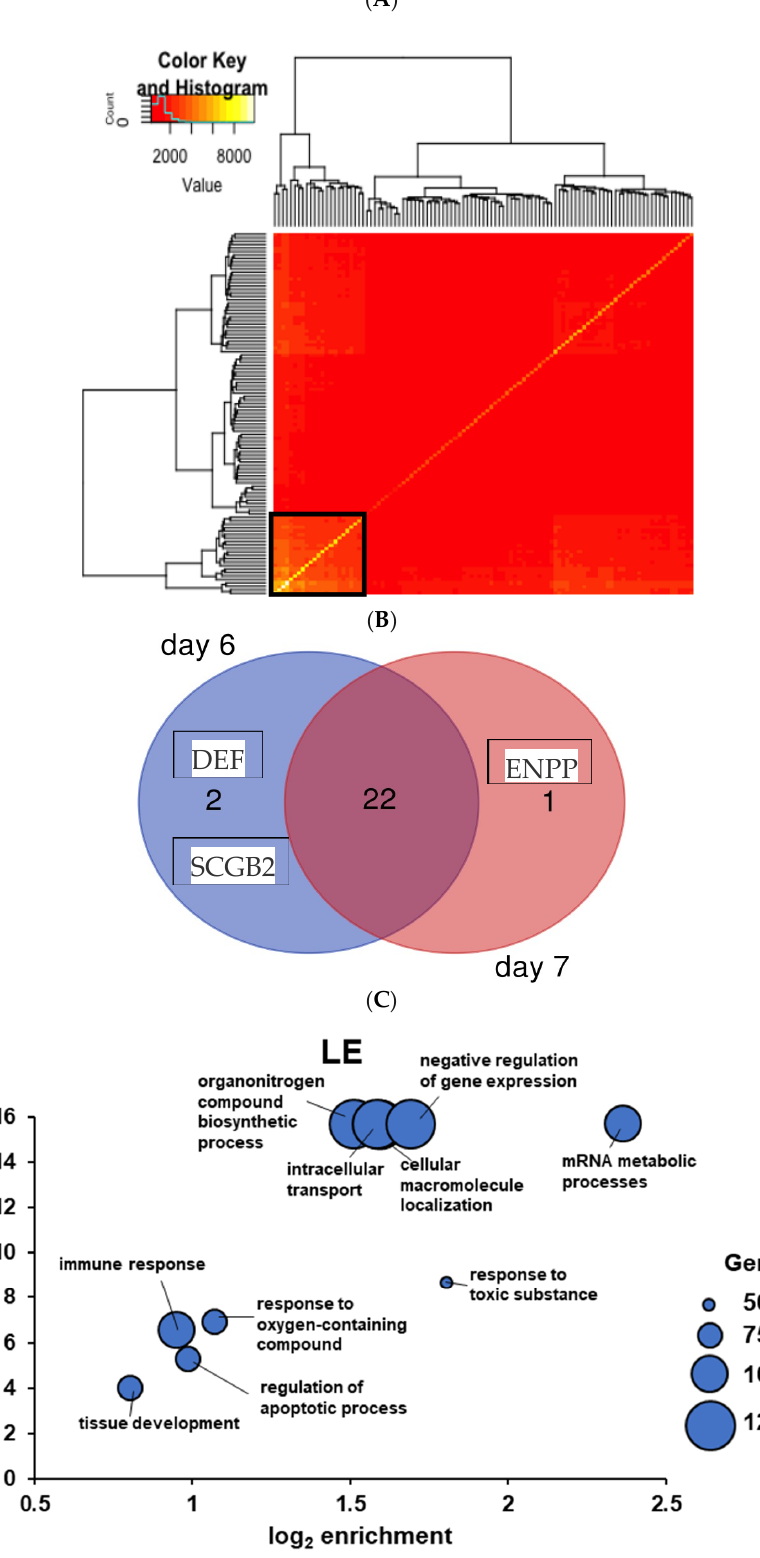
Figure 6. ( A ) Hypernetwork analysis demonstrating the correlations between LE genes with cognate cell-surface genes in day 6 TE against the rest of the luminal transcriptome. Hierarchical clustering based on the dendrogram identified gene clusters (black box) that share highly connected